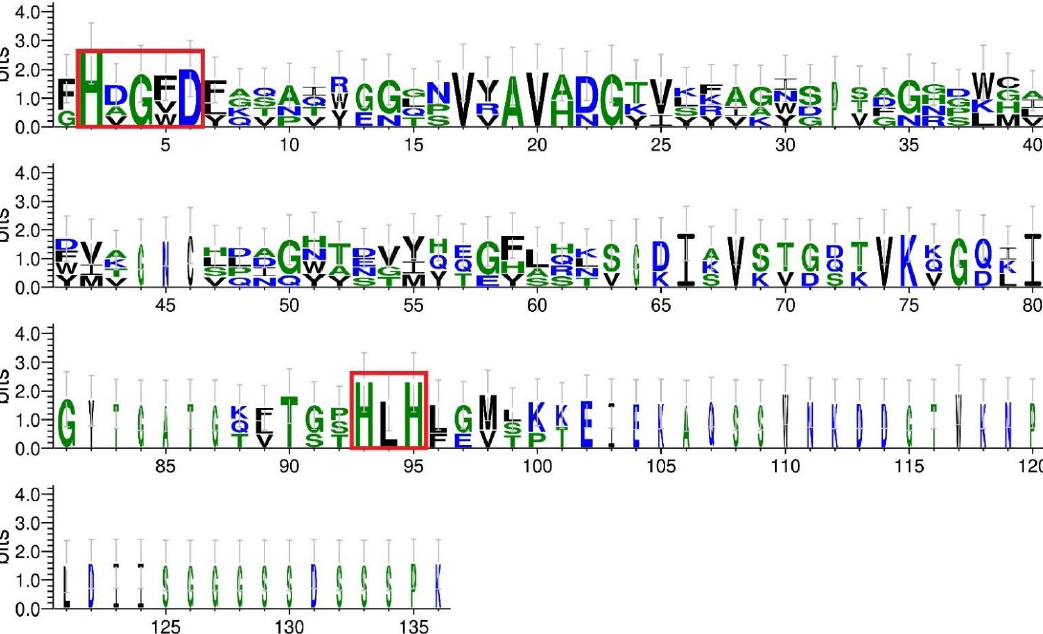
Figure 1. Logo motif representation for 280–404 region in BLF3872 bacteriocin corresponding to the peptidase M23 domain and peptidase M23 domain from enterolysin A, zoocin A, and zoocin A peptidase family M23. Logo profiles were generated using WebLogo 3 server [64]. Conserved motifs corresponding to the potential zinc binding site are